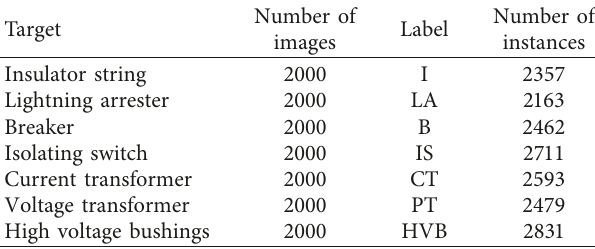
Table 1: Data statistics of the dataset.